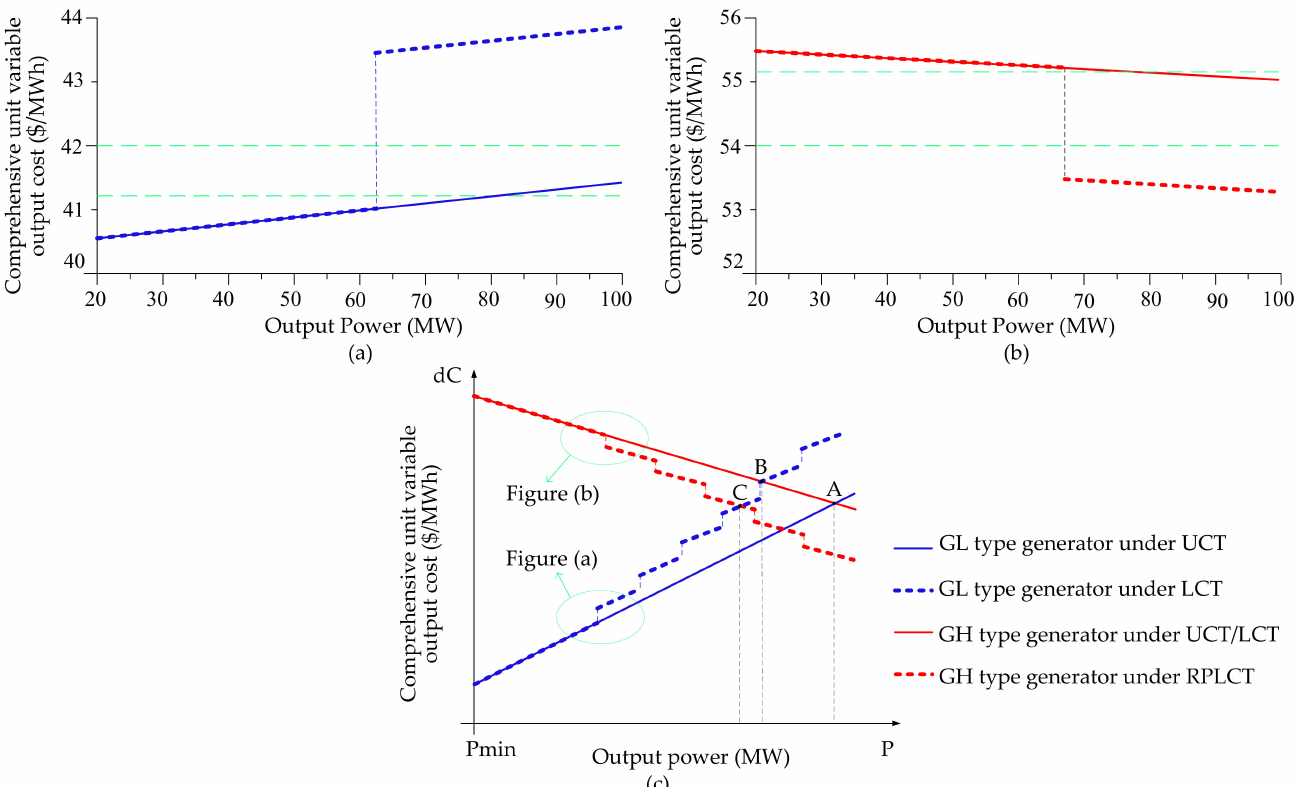
Figure 2. Comparison of three carbon trading